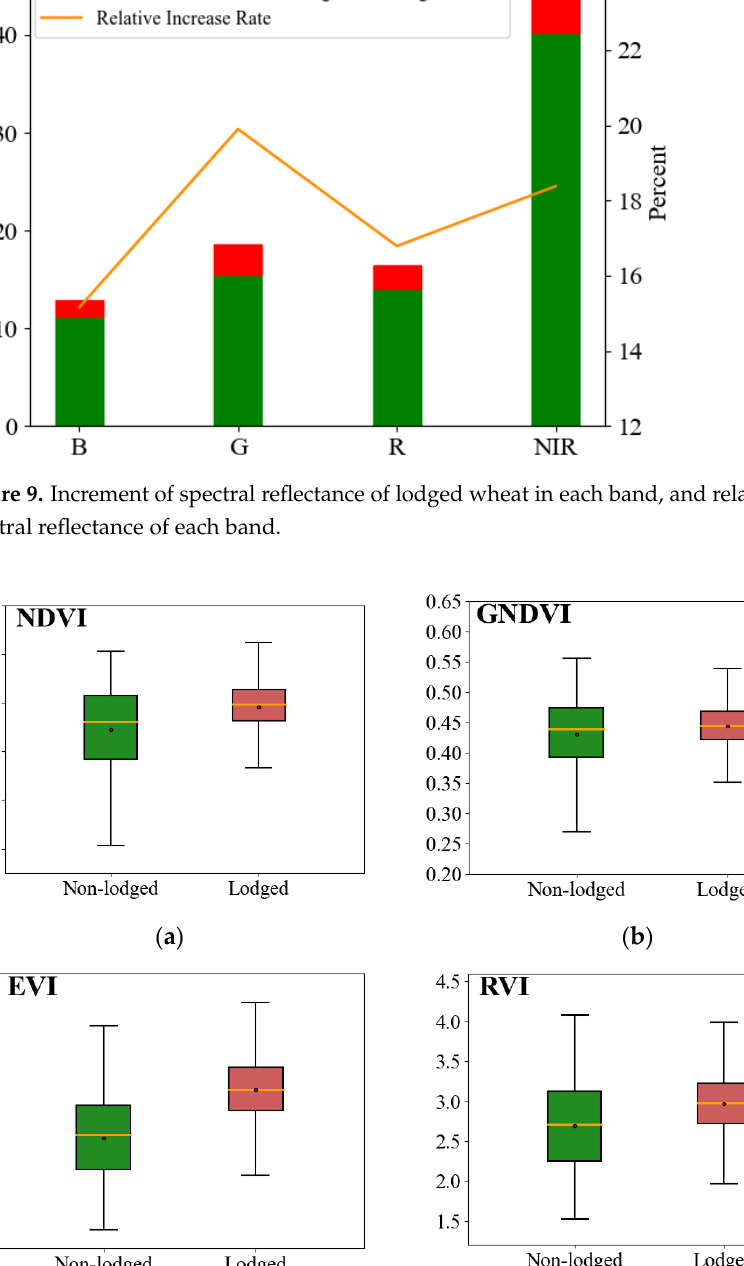
Figure 8. Changes in spectral reflectance of each band: ( a ) histogram of spectral reflectance in four bands; ( b ) mean spectral reflectance change within each band and wheat lodging conditions.